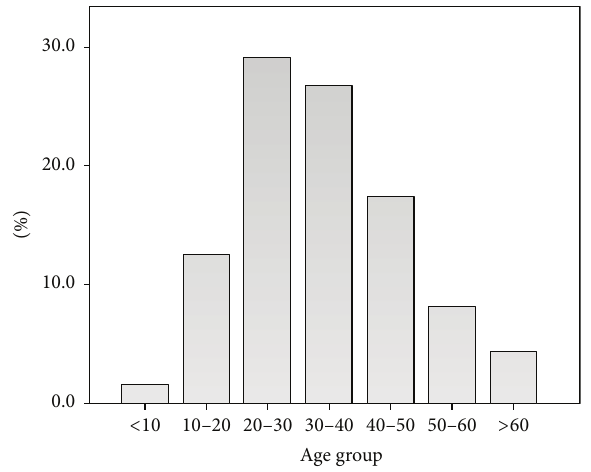
Figure 1: Age distribution of all root canal treatment